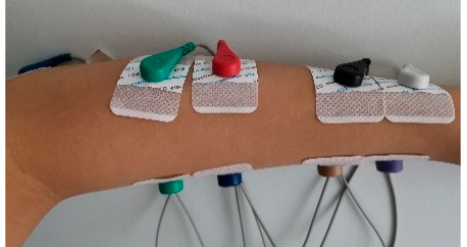
Figure 4. The positions of the electrodes. We adopted 4-channel differential input in signal acquisition and took the elbow as the reference. The acquisition positions located on extensor pollicis longus, finger extensor muscle, and the palm long extensor muscle.